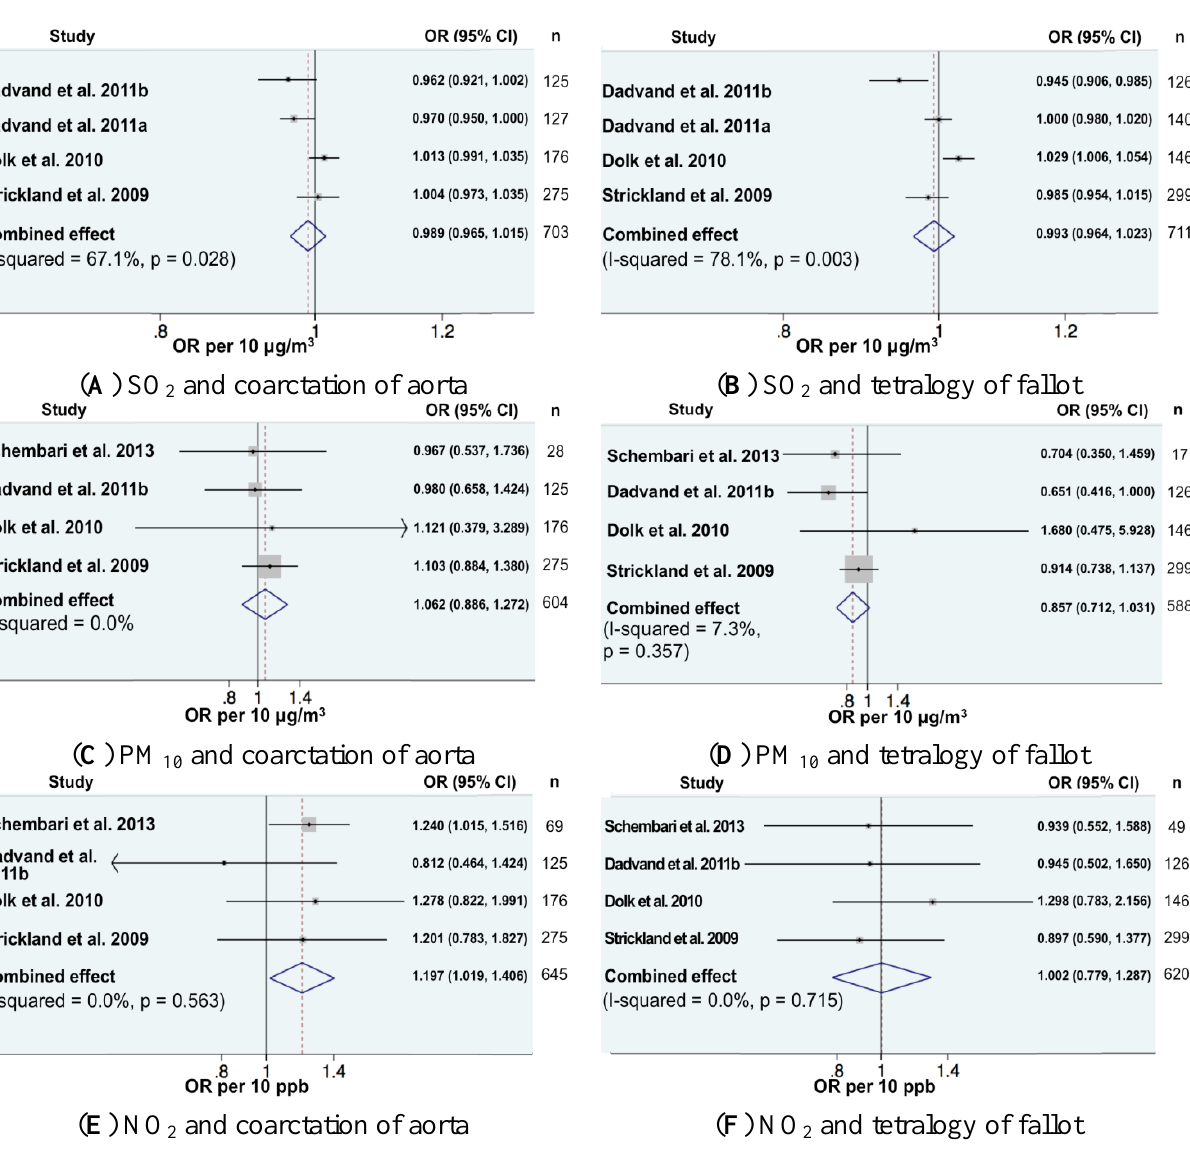
Figure 3. Forest plots for combinations of two cardiac anomalies (coarctation of aorta and tetralogy of fallot) and pollutant. The size of each square represents the weight that contributes to the combined effect. ( A ), ( C ), ( E ) were combined effects of coarctation of aorta and SO , PM and NO . ( B ), ( D ) and ( F ) were combined effects of tetralogy of fallot 2 10 2 and SO , PM and NO 2 10 2